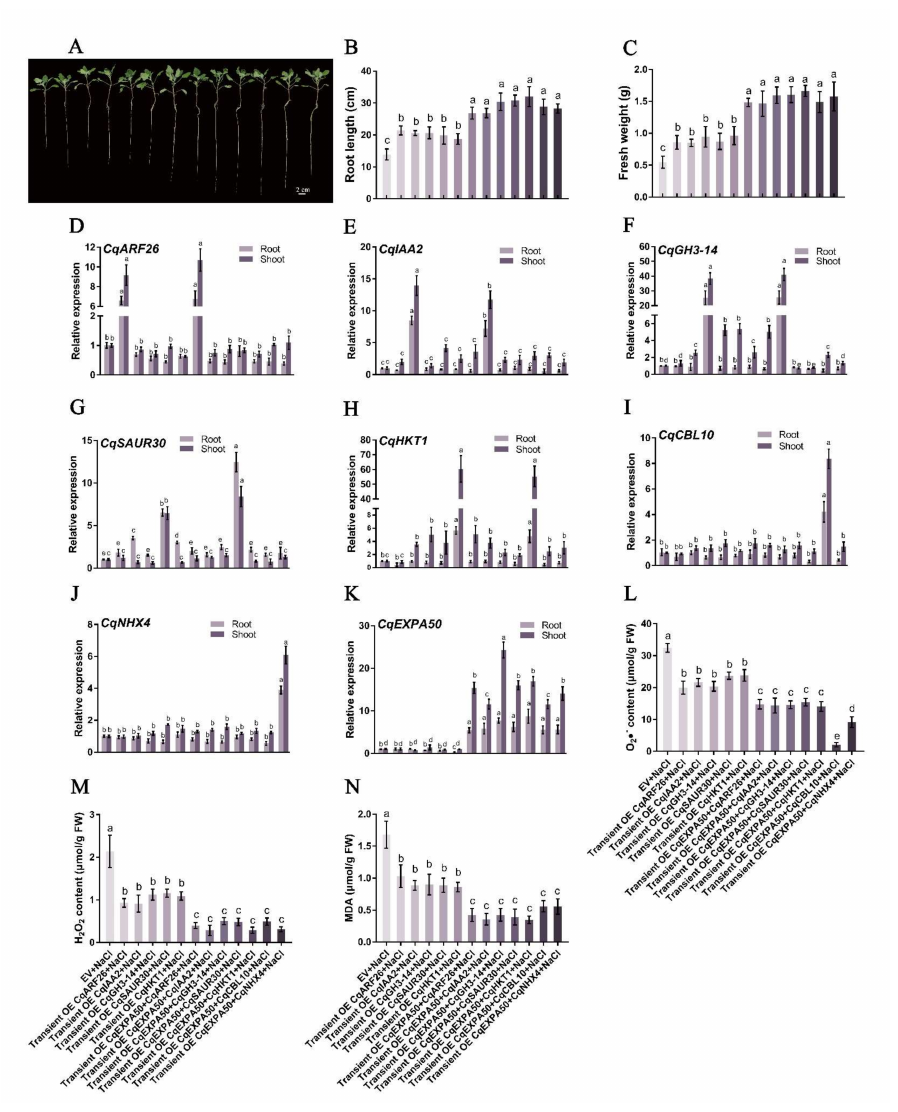
Figure 9. CqEXPA50 participates in salt tolerance of quinoa seedling roots together with CqARF26, CqIAA2, CqGH3-14, CqSAUR30, CqHKT1, CqCBL10 or CqNHX4. Relevant indicators of all these quinoa seedlings roots in different treatments were determined. ( A ) The effects of simultaneous transient overexpression on the phenotype of quinoa seedlings under salt stress. Bar = 2 cm. ( B ) The root length. ( C ) The fresh weight. ( D ) Expression analysis of CqARF26 in quinoa root and shoot under salt stress after transient overexpression. ( E ) Expression analysis of CqIAA2 in quinoa root and shoot under salt stress after transient overexpression. ( F ) Expression analysis of CqGH3-14 in quinoa roots under salt stress after transient overexpression. ( G ) Expression analysis of CqSAUR30 in quinoa roots under salt stress after transient overexpression. ( H ) Expression analysis of CqHKT1 in quinoa roots under salt stress after transient overexpression. ( I ) Expression analysis of CqCBL10 in quinoa roots under salt stress after transient overexpression. ( J ) Expression analysis of CqNHX4 in quinoa roots under salt stress after transient overexpression. ( K ) Expression analysis of CqEXPA50 in quinoa roots under salt stress after transient overexpression. ( L ) The O2 • − content changes in quinoa roots under different treatments. ( M ) The H 2 O 2 content changes in quinoa roots under different treatments. ( n = 3). Different letters (a–e) in Figure 9B − N indicate significant differences at p < 0.05 according to one-way ANOVA (comparing the mean of each column with the mean of every other column) in GraphPad Prism